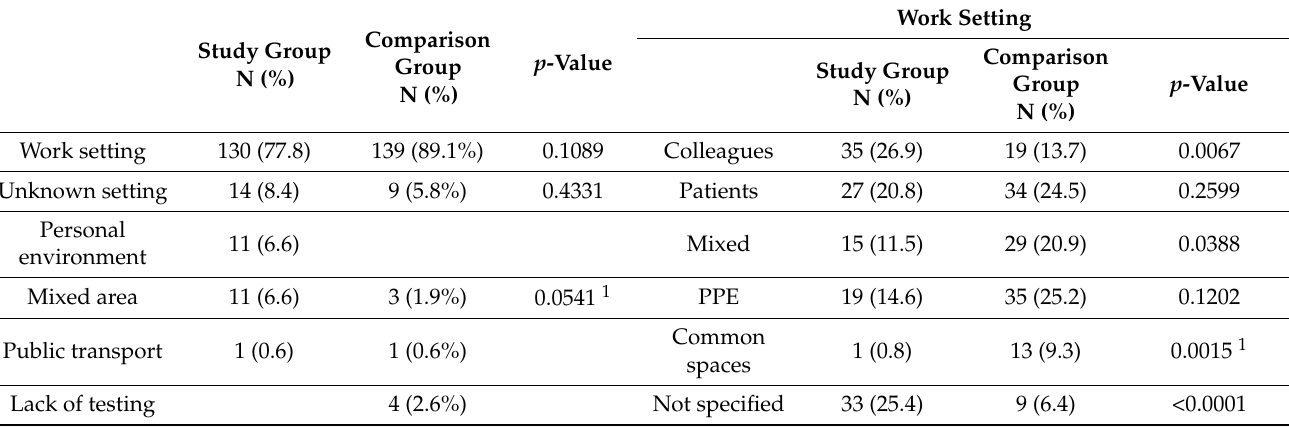
Table 3. Healthcare professionals’ perception of risk.